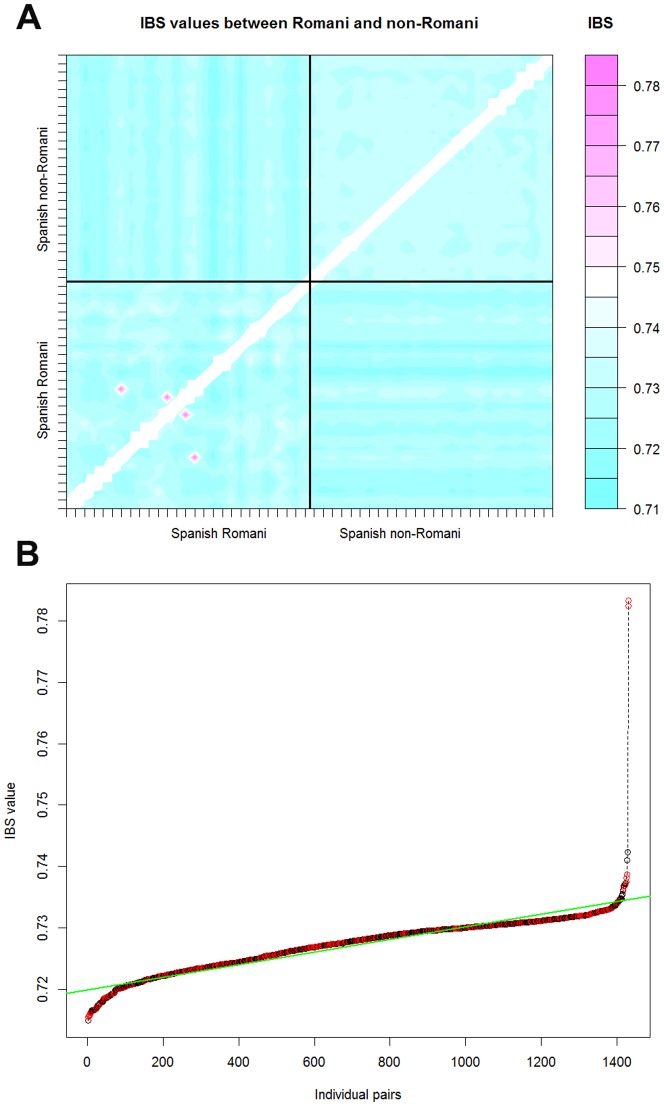
Analysis of IBS carried out on Romani and non-Romani individuals based on genome-wide SNP data.(A) IBS values between Romani and non-Romani individuals. The non-Romani population sample was taken from the same Spanish region where the Romani samples were collected for the present study. The pink dots correspond to the two pairs of Romani individuals showing much higher IBS values than those observed between other Romani or non-Romani individuals. (B) All pairs of IBS values between Romani and non-Romani individuals are sorted from the lowest to the highest; the two highest values on the right of the figure correspond to the two pairs of Romani individuals in Figure 1A.